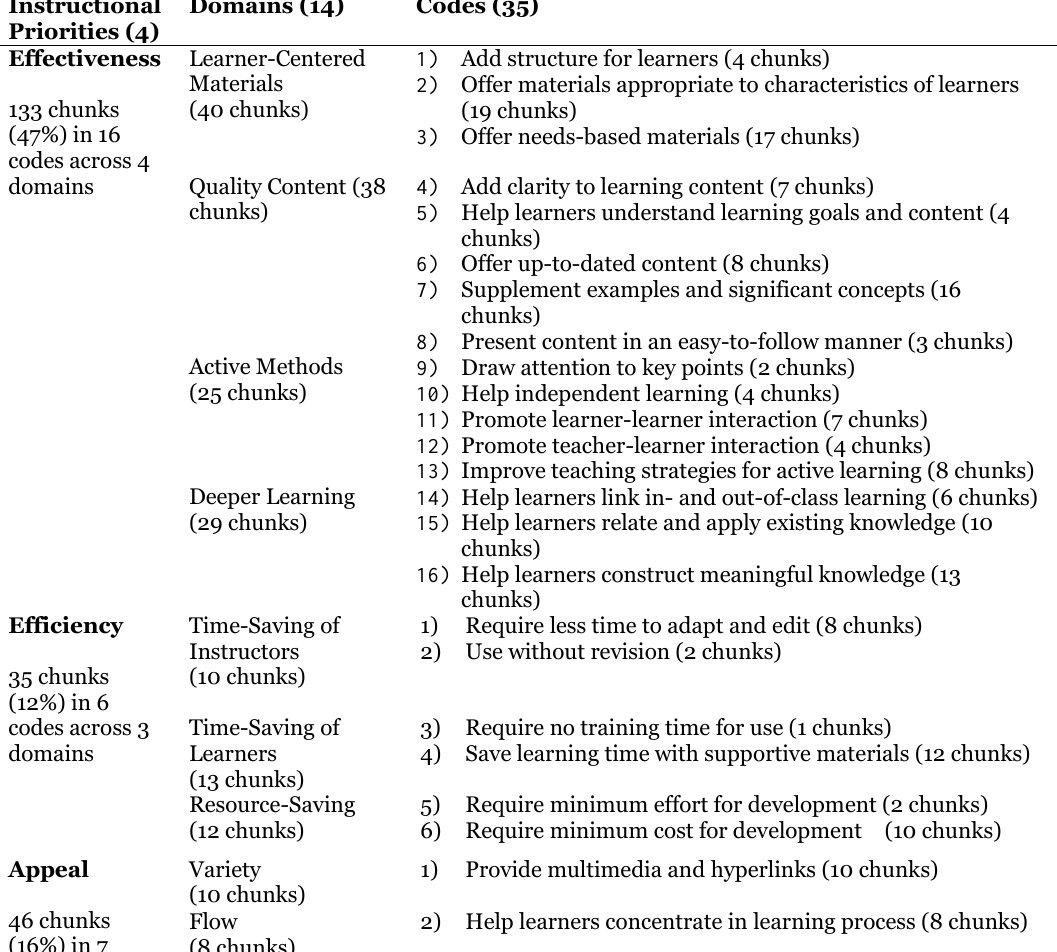
Coding and Categorization of Instructional Priorities of Using OER